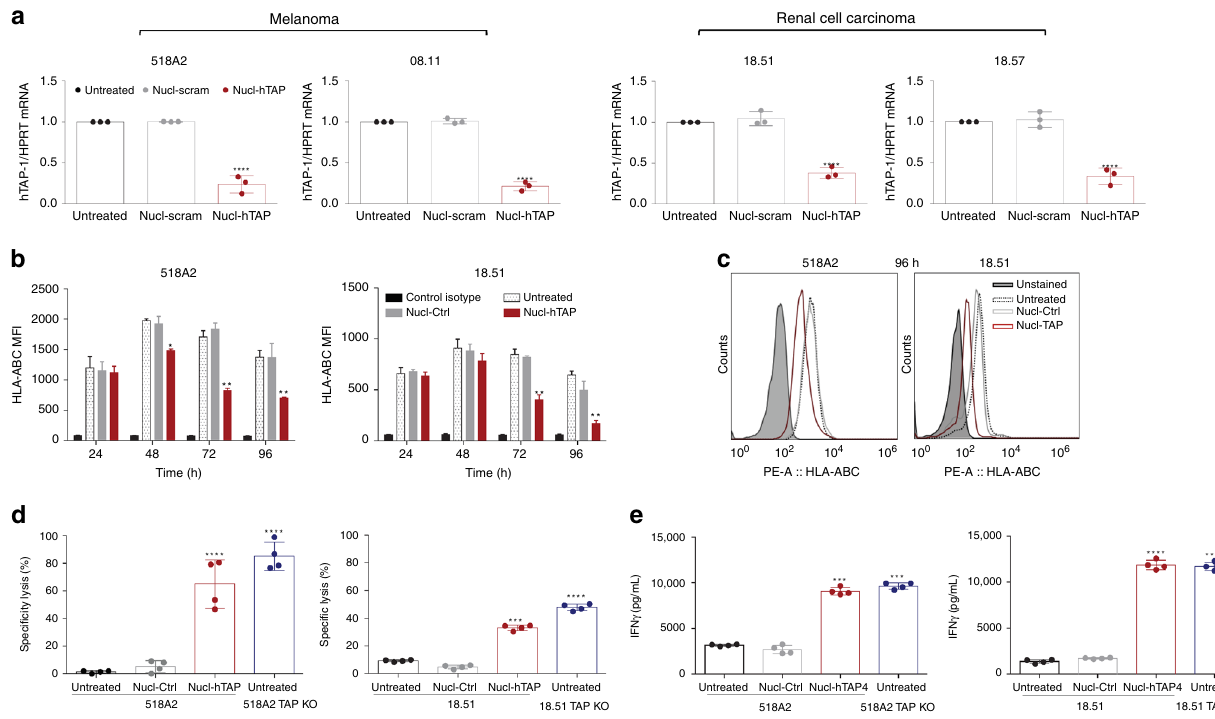
Fig. 6 Presentation of a TAP-downregulation-induced peptide in human tumors treated with Nucl-TAP. a Downregulation of TAP mRNA in human tumor cells incubated with Nucl-TAP. Cells were treated with Nucl-siRNAs and 24 h later mRNA was isolated and quanti fi ed by qRT-PCR. Data represent means and SEM performed in triplicates ( n = 2). b and c Downregulation of HLA-A, B, and C analyzed by fl ow cytometry at different times as indicated ( n = − 3). b Data represent means and SEM performed in quadruplicates. c Representative experimental well at 96 h. d and e Presentation of a TAP downregulation- induced peptide in TAP-de fi cient (TAP KO) or TAP-suf fi cient 518A2 and MZ18.51 tumor cells treated with Nucl-siRNAs for 72 h, and cultured with a CD8 + T cell clone that recognized the HLA-A2-TAP downregulation-induced peptide complex 29 . d In vitro cytotoxicity after 4 h coculture was determine by lactate dehydrogenase assay. e INF γ production after 20 h stimulation was measured by ELISA. Means and SEM of quadruplicate wells ( n = 1). Statistical analyses using one-way ANOVA test and Dunnet posttest for comparison between untreated and treated cells. Differences are indicated: **** P < 0.001, *** P < 0.005, ** P < 0.01, * P <